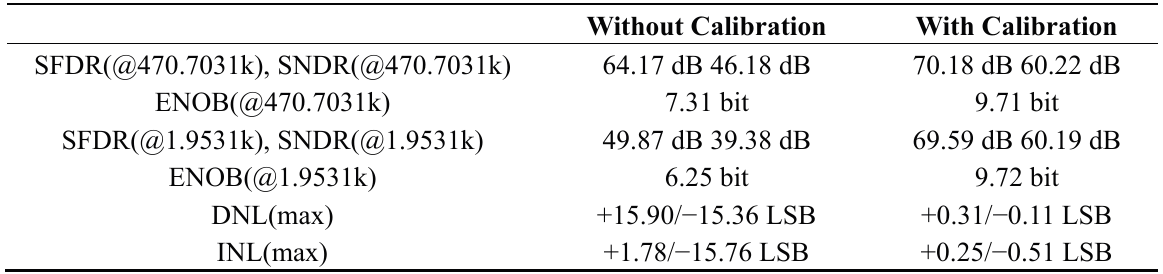
Table 1. Simulated result